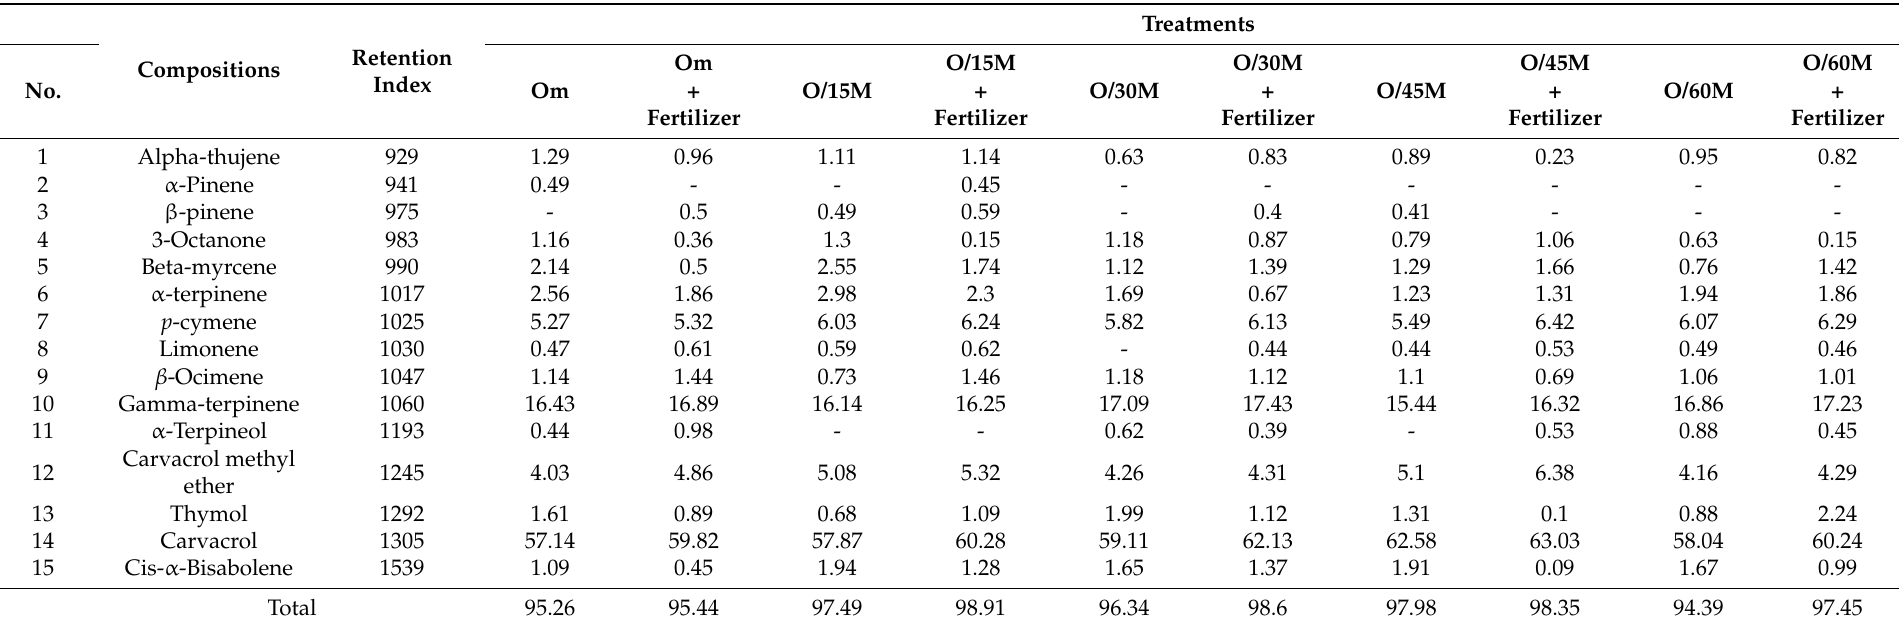
Table 3. The essential oil compositions of marjoram under different cropping patterns and biofertilizers